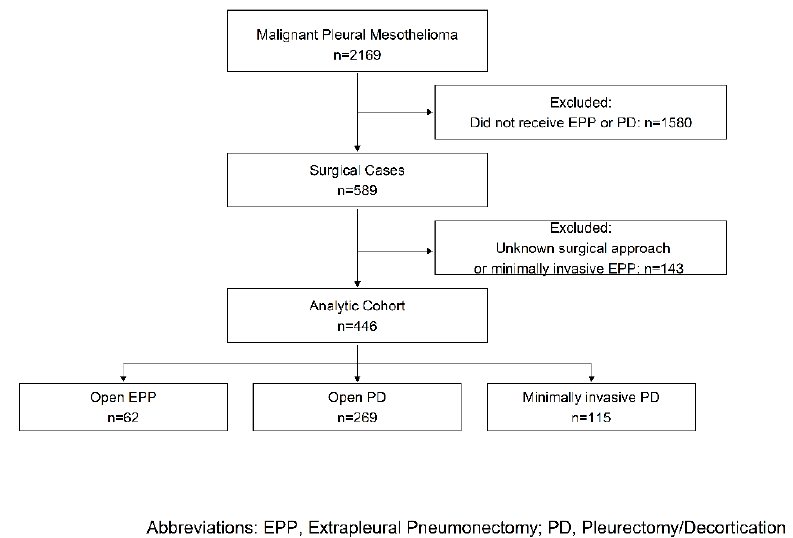
Figure 1. Patient Selection